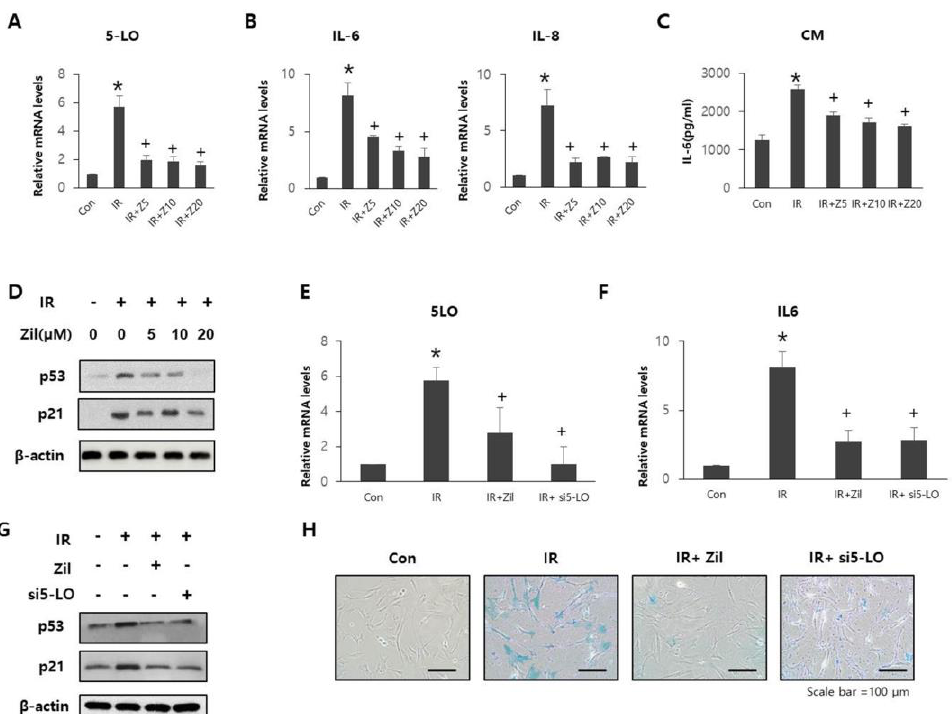
Figure 3. Attenuation of radiation-induced cell senescence and SASP through 5-LO inhibition. ( A – D ) HDFs were cultured with various concentrations of zileuton (0, 5, 10, or 20 μM) for 24 h after radiation exposure ( Con: control, IR: irradiation group, Z5: 5 μΜ zileuton treatment, Z10: 10 μΜ zileuton treatment, Z20: 20 μΜ zileuton treatment). ( A , B ) mRNA expression levels of 5LO, IL-6,